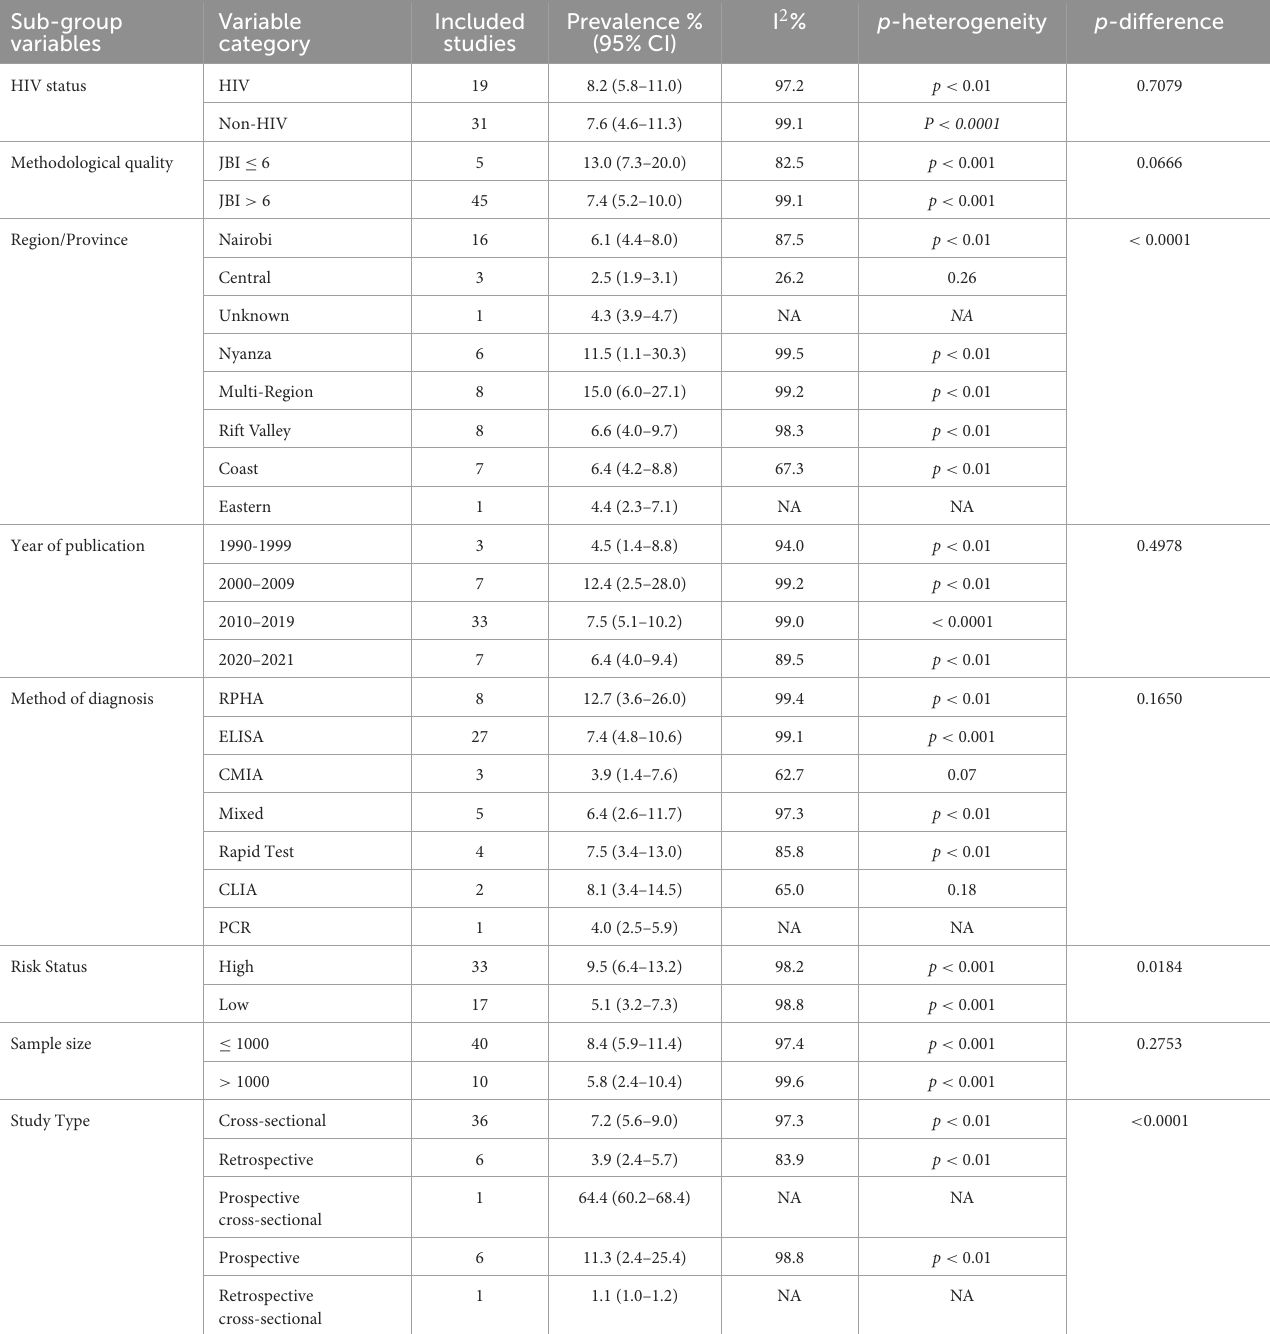
TABLE 2 Subgroup analysis of the studies reporting the prevalence of HBV in Kenya. Sub-group